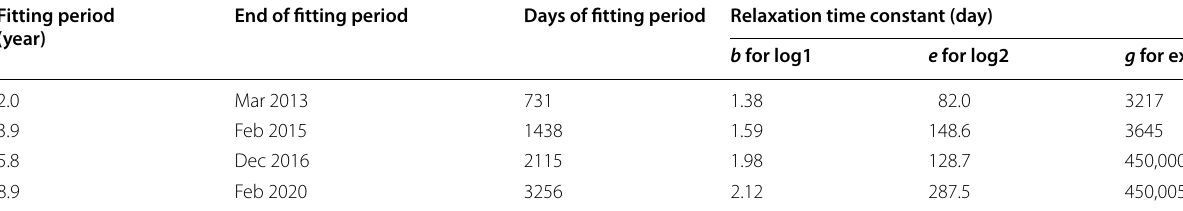
Table 1 Results of data fitting for each fitting period Fitting period